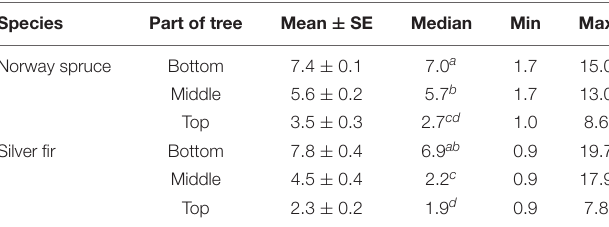
TABLE 1 | Average time of water absorption by non-silicone bark samples (days) where letters denote difference among parts and tree species based on the Kruskal–Wallis test ( p <